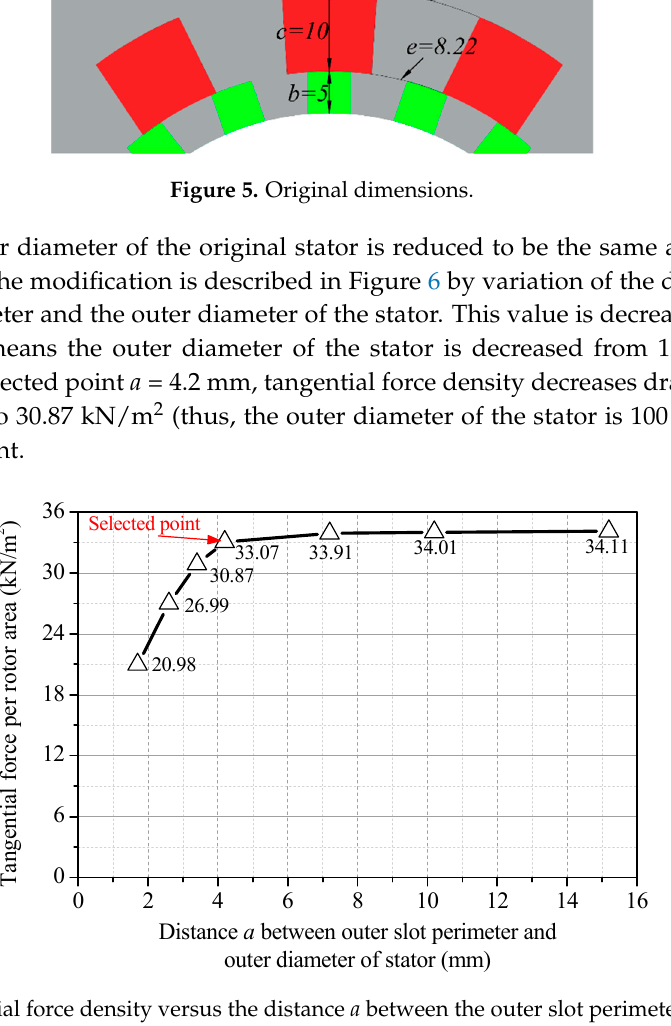
Figure 5. Original dimensions.